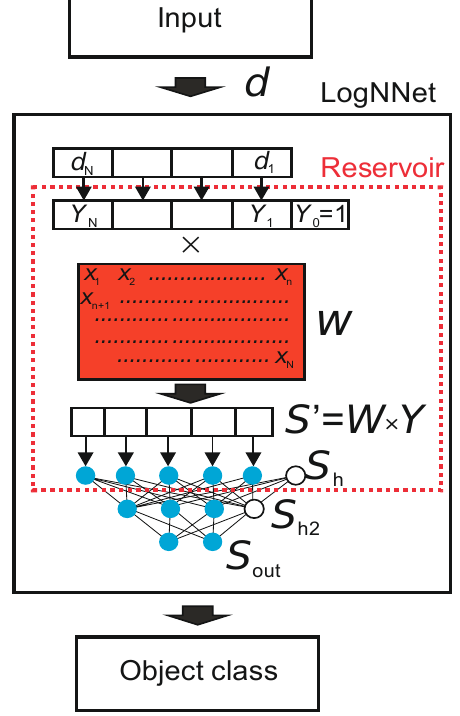
Figure 2. LogNNet architecture [43].